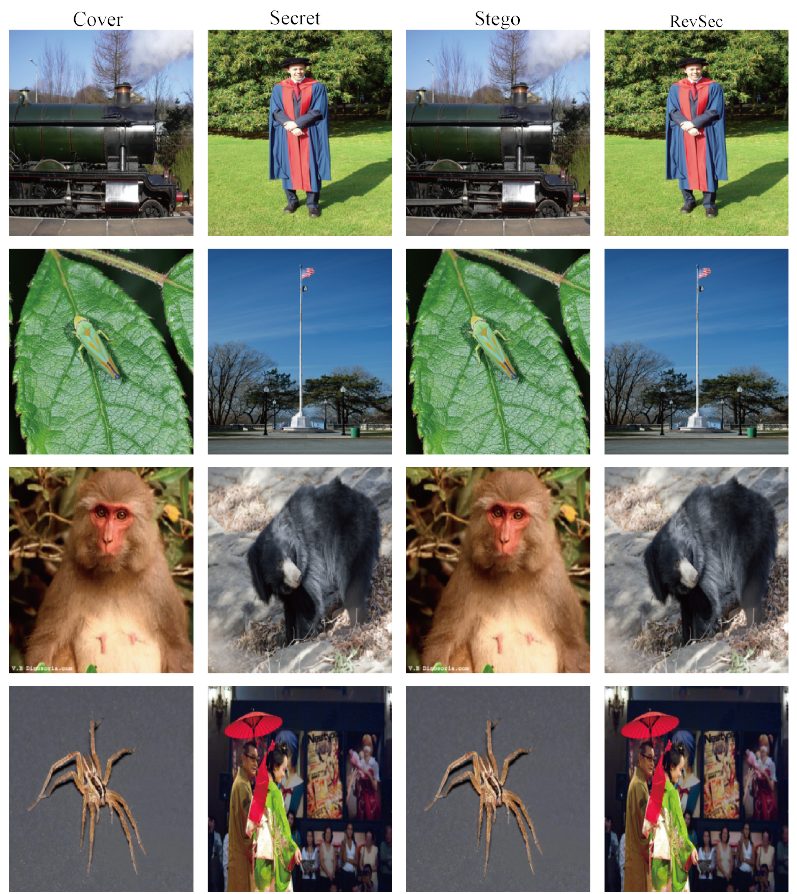
Figure 8. Four sets of experimental results randomly drawn for load capacity